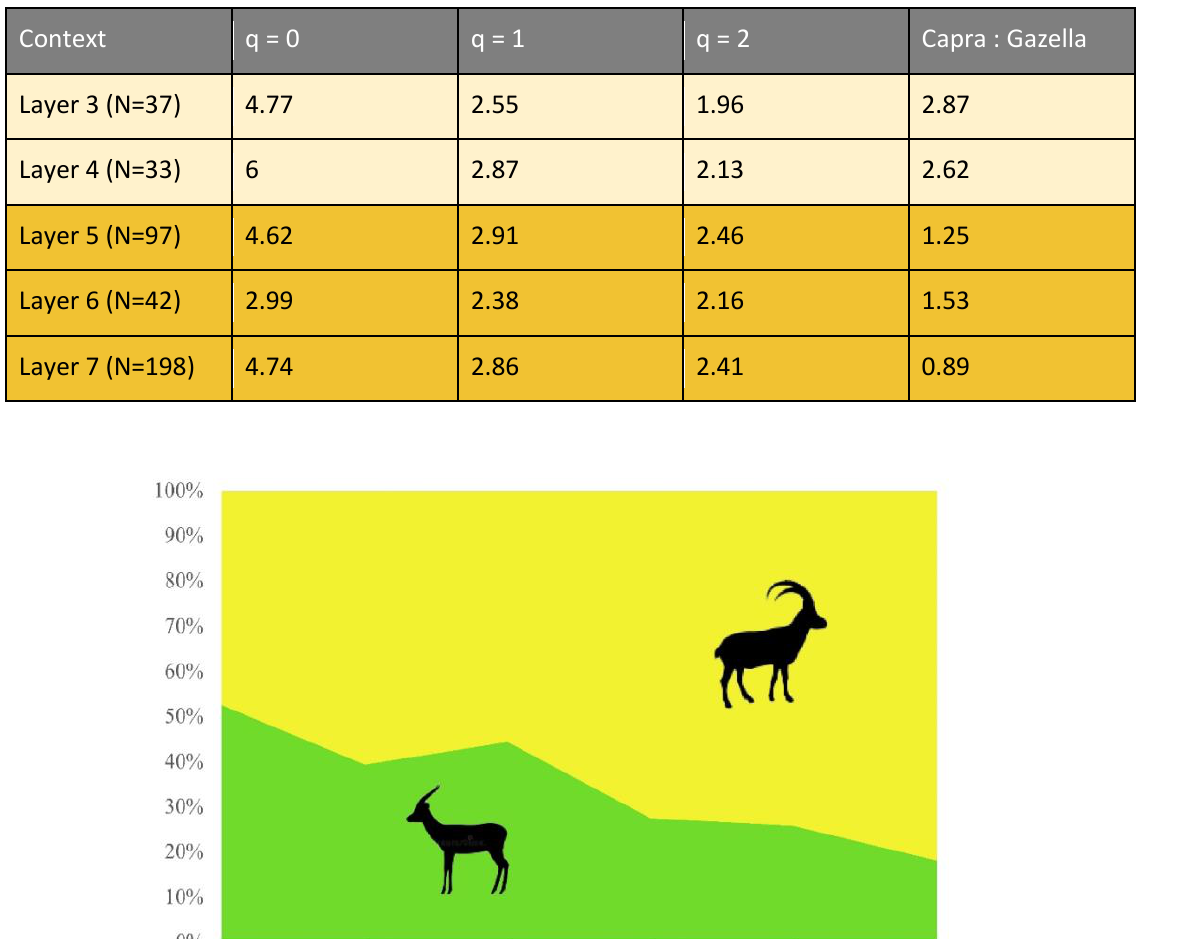
Table 3: Hill numbers reflect the ENS (“effective number of species”) under different values of q, with q=0 reflecting richness, q=1 the exponent of Shannon diversity, and q=2 the reciprocal of Gini-Simpson index. The values were calculated using individual rarefaction for NISP=33, the size of the smallest sub- sample (Layer 4).